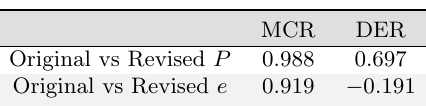
Table 5: Spearman’s rank correlation coefficient, ρ , for the 10 × 10